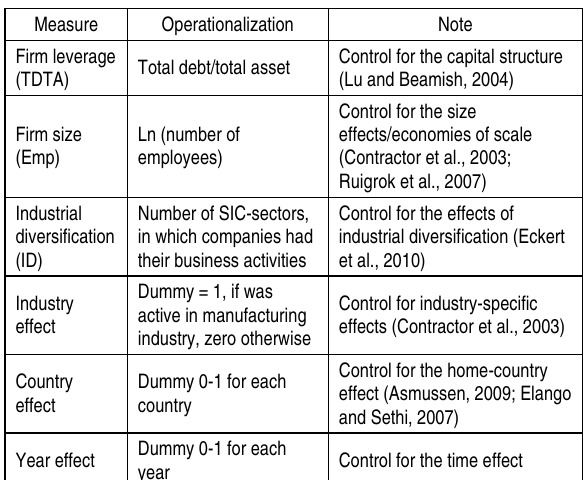
Table 2. Overview of the control